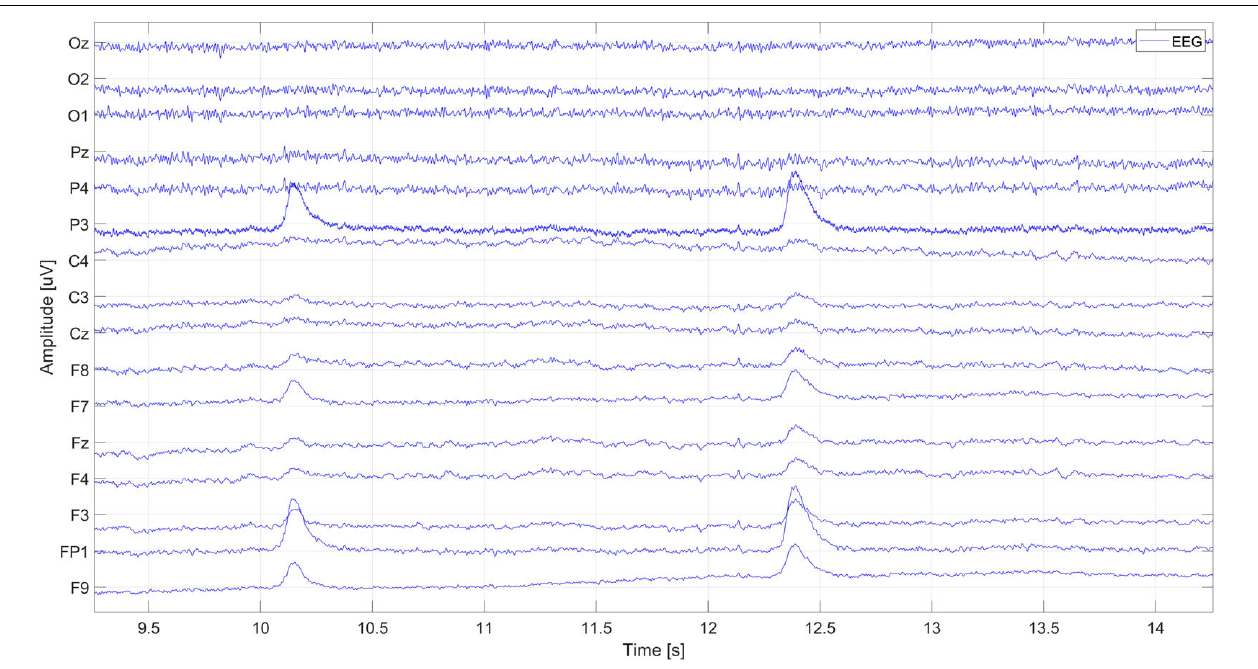
FIGURE 3 | Recorded EEG signal